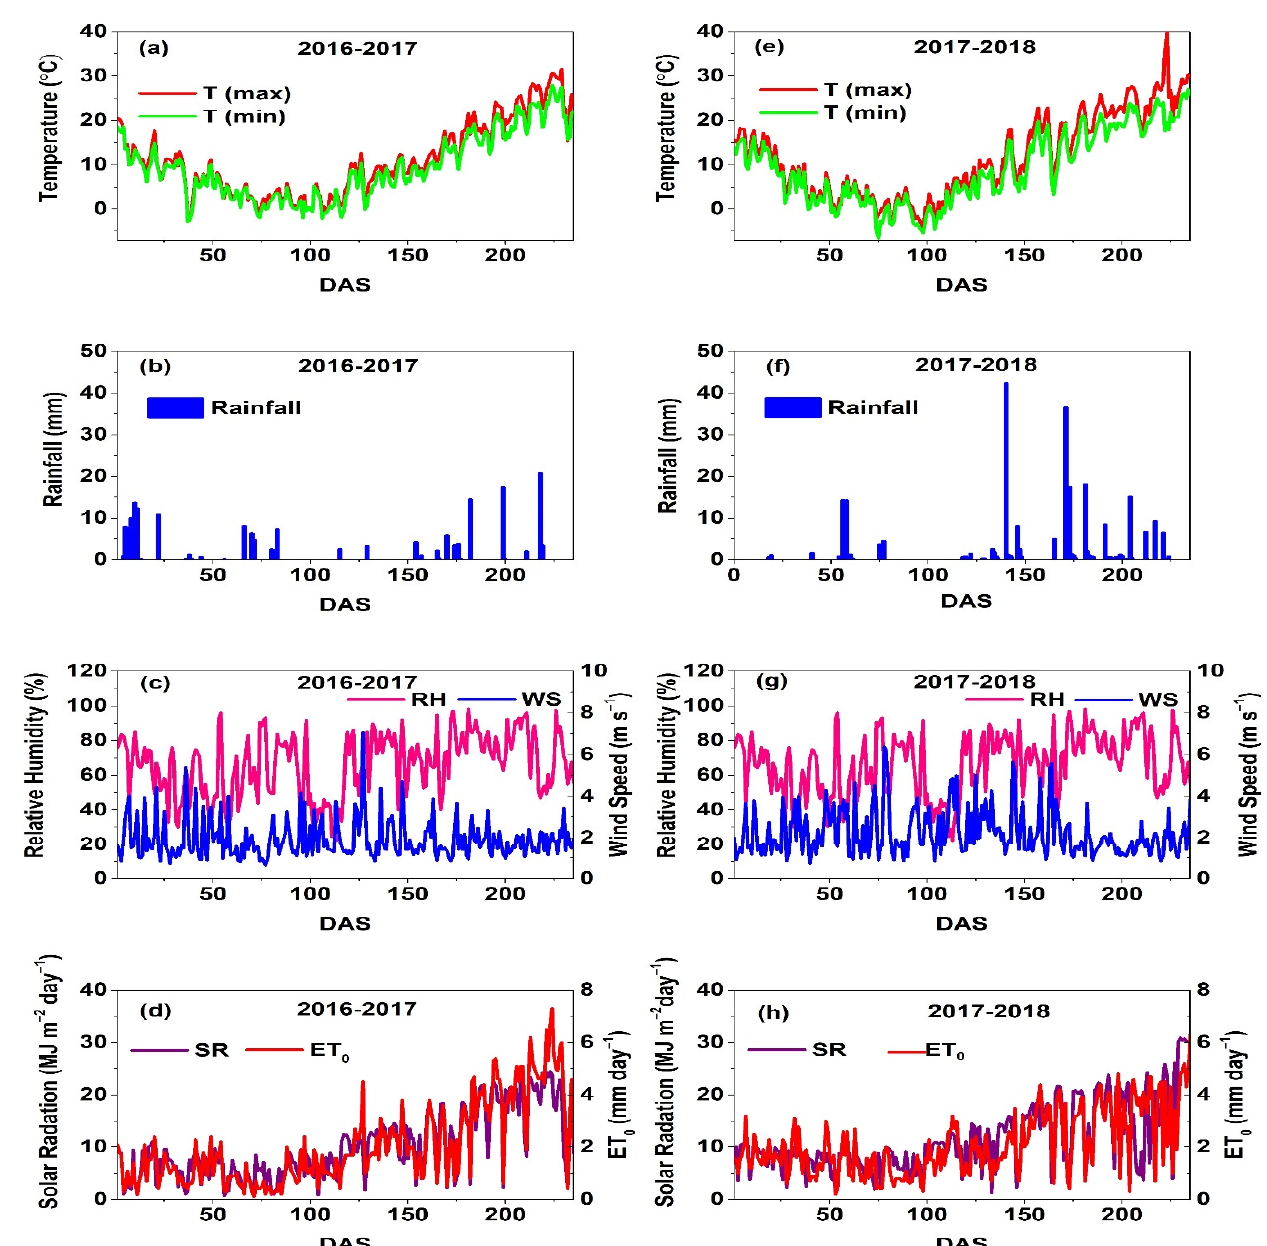
Figure 2. Daily maximum and minimum air temperature ( a , e ), rainfall ( b , f ), relative humidity and wind speed ( c , g ), solar radiation (SR) and reference evapotranspiration (ET 0 ) ( d , h ) trends on the day after sowing (DAS) during the study period in 2016 − 2017 and 2017 − 2018.